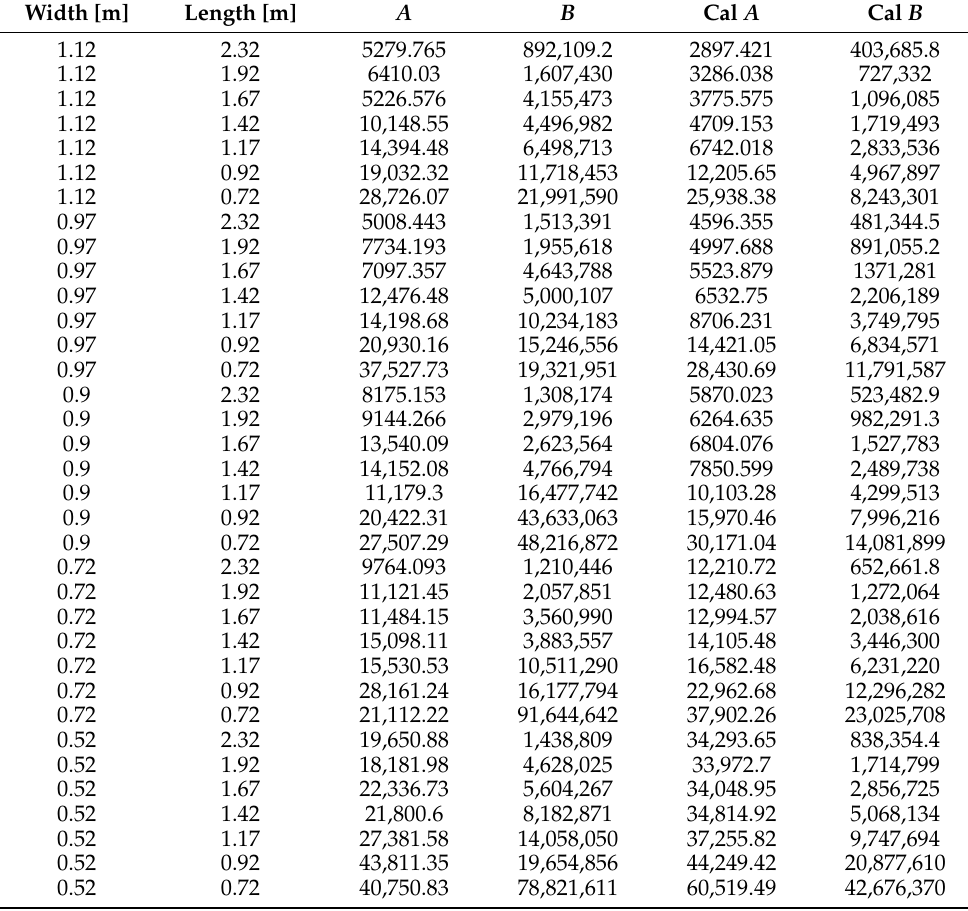
Table A6. The 10 mm plate Polygal vacuum tests A , B and theory calculated A , B .